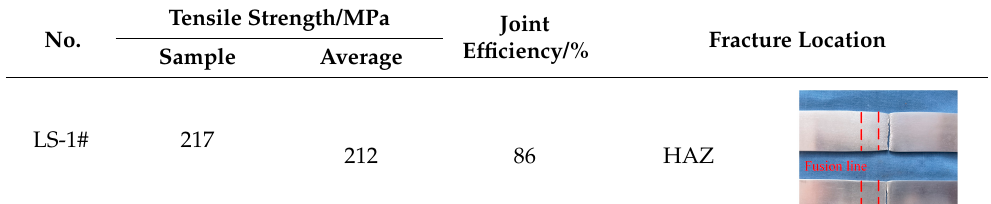
Table 4. The tensile testing results of the joints.